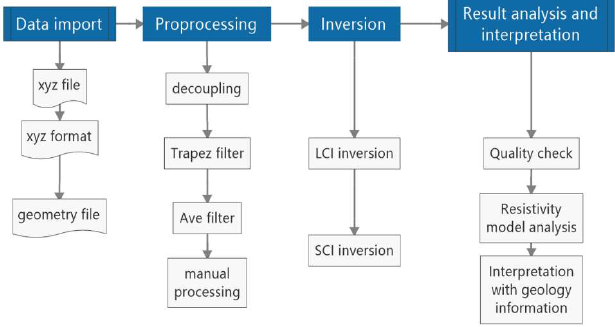
Figure 4. The data processing flow for Qingchengzi VTEM data.